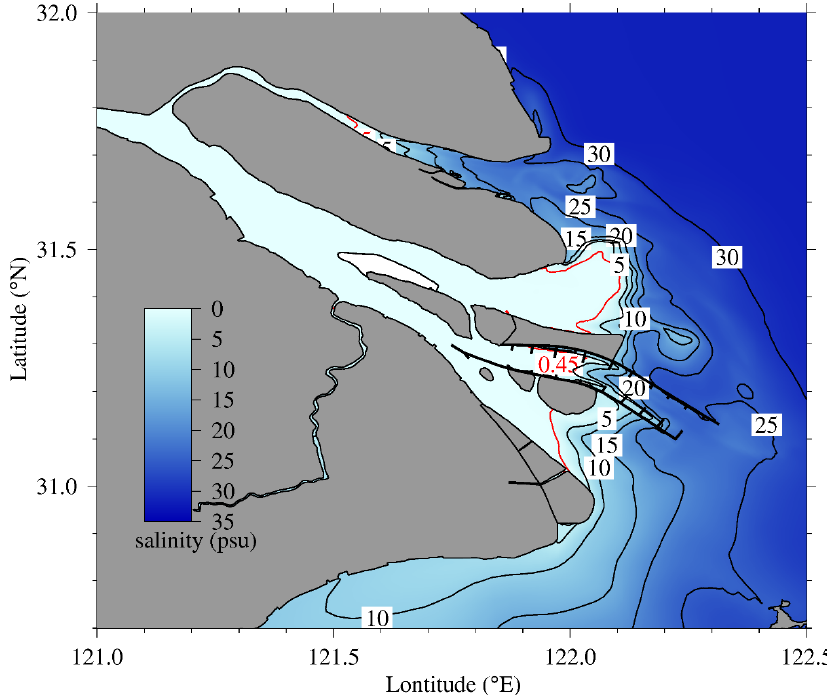
Figure 7. Modeled depth-averaged salinity distribution at the flood slack during the spring tide in EX0.